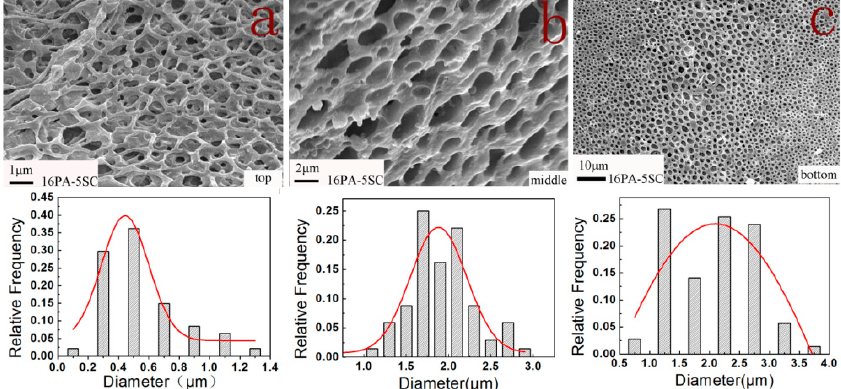
Figure 3. SEM images of the structural changes and pore size distribution along the foaming direction: ( a ) top, ( b ) middle and ( c ) bottom part of 16PA-5SC.